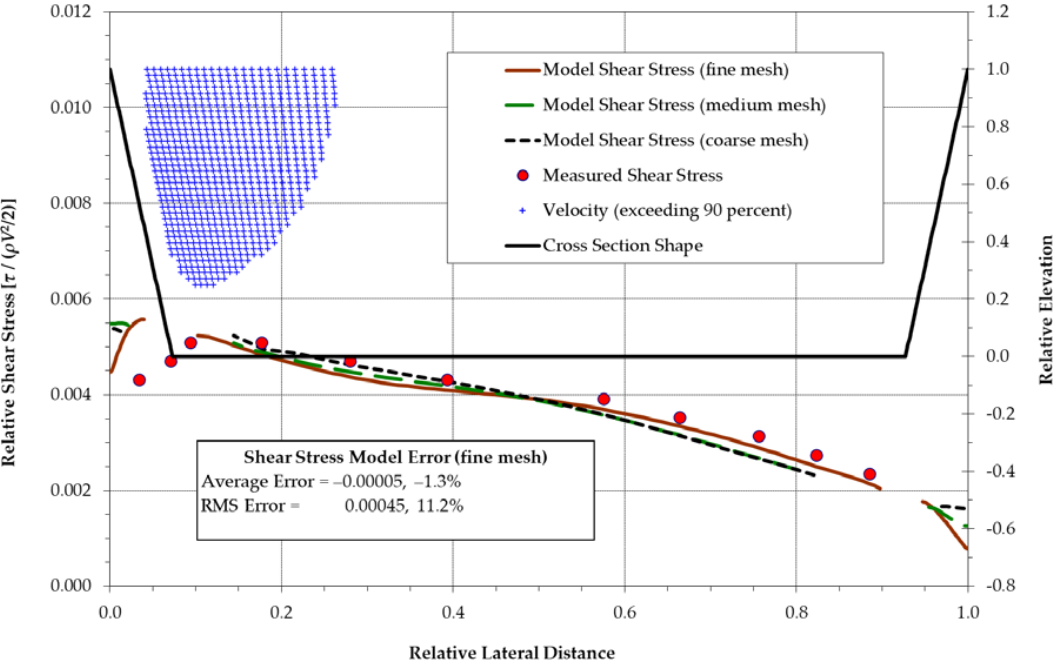
Figure 16. Comparison of simulated and measured shear stress for cross-section π /16 (11.25° through the second channel curve). The channel cross section is also plotted along with the location of greatest velocity (within 90% of maximum velocity).